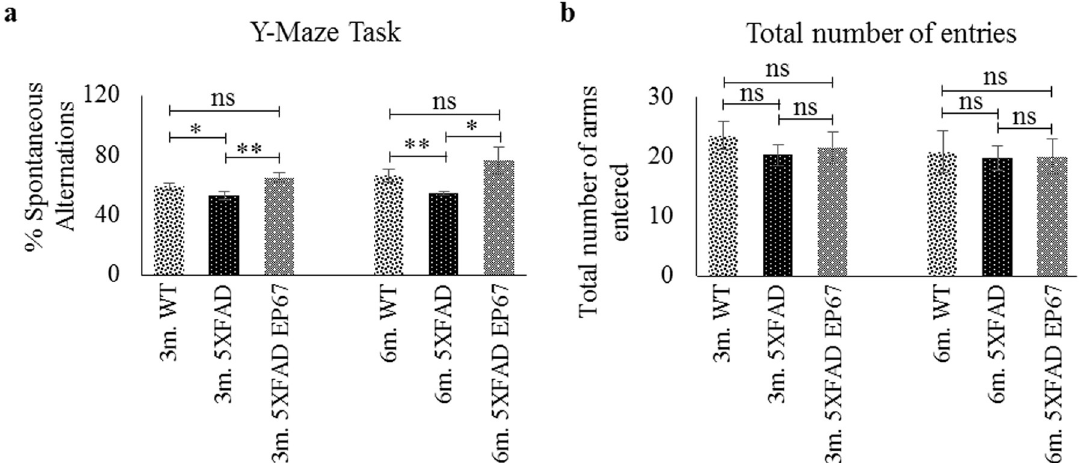
Fig 5. Y-maze task. (a) Wild type, 5XFAD and 5XFAD EP67 treated mice of 3 and 6 months of age were given the spontaneous alternation behavioural test using a Y-maze. (b) The number of arm entries for each group was recorded and exhibited no significant difference among any group of animals. n = 6/group/age. Mean ±